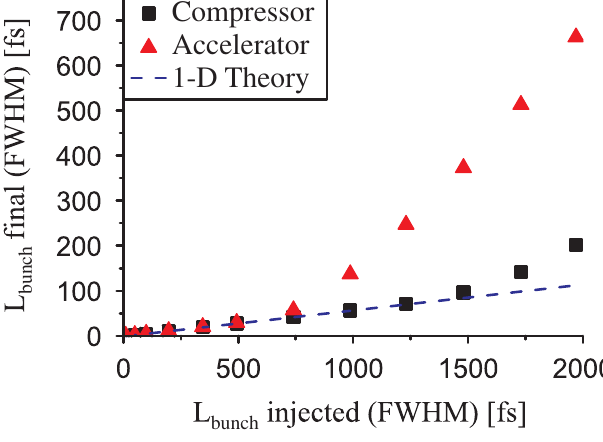
FIG. 7. (Color) Bunch length after compression as a function of the bunch length before compression for both the accelerator scheme and the compressor scheme compared to the theoretical compression of Eq. (1).